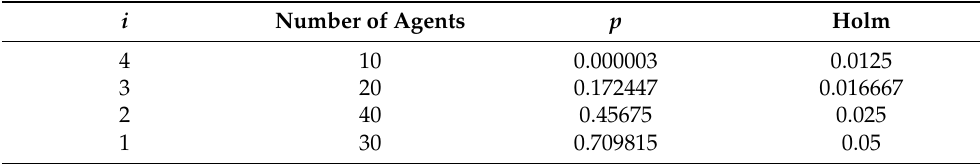
Table 3. Holm Post Hoc for Number of